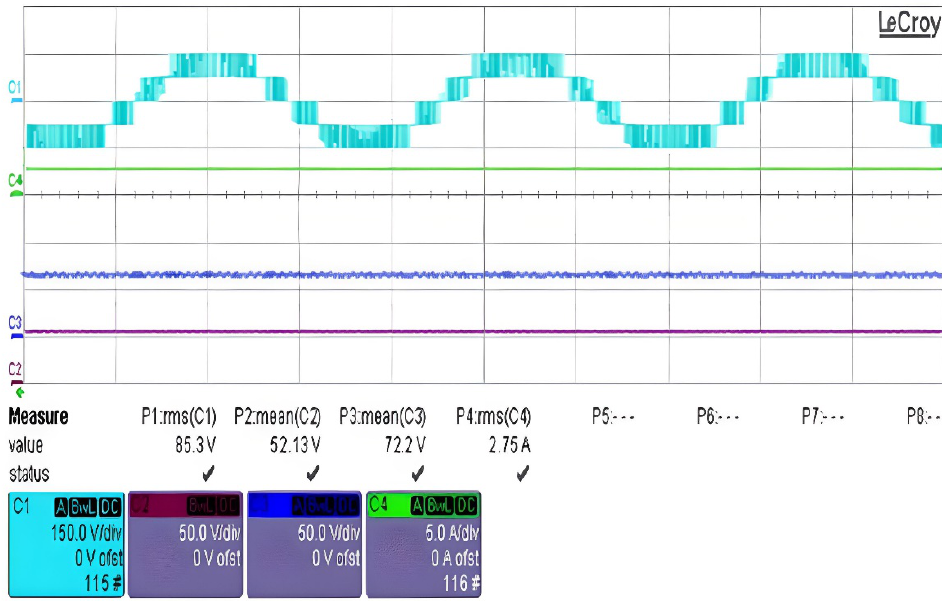
Figure 16. Experimental waveforms showing: inverter output voltage (C1), PV array voltage (C2), capacitor voltage (C3) and PV array current (C4).